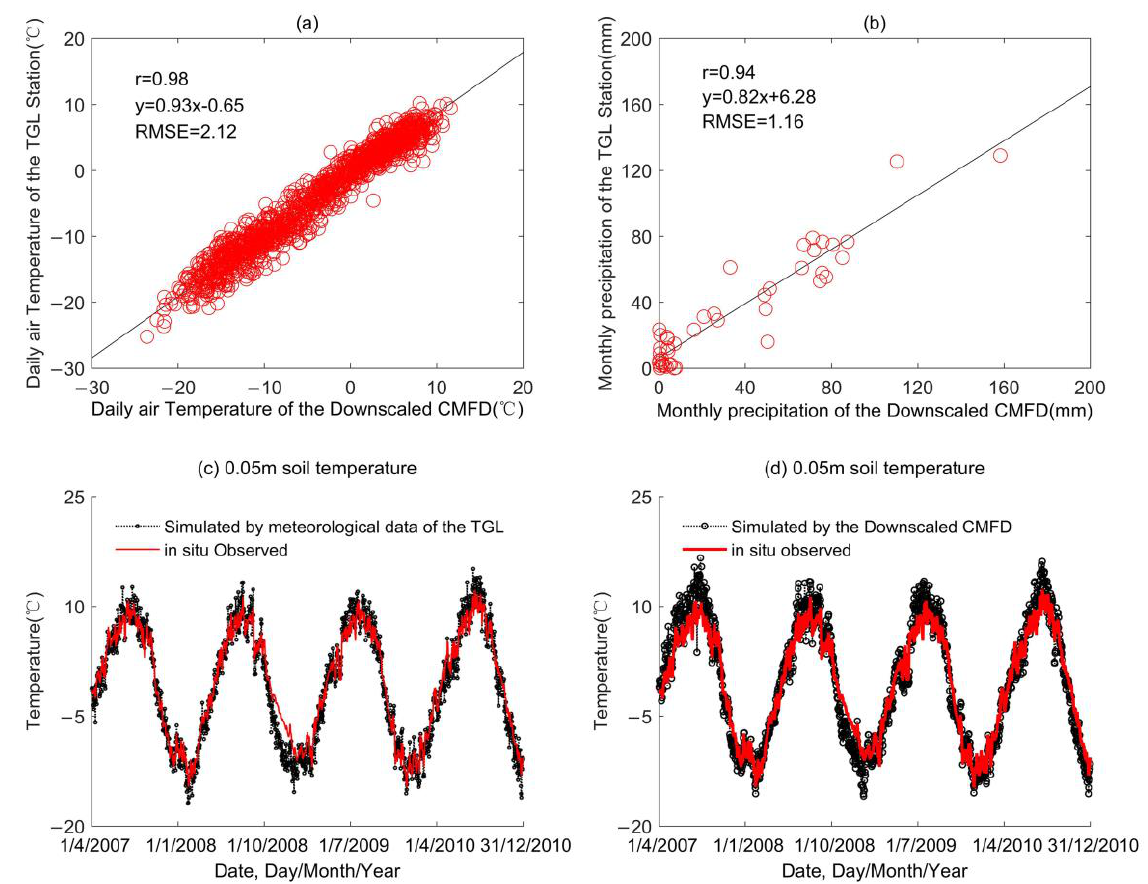
Figure 2. Plots of ( a ) the 2 m daily air temperature; ( b ) the monthly precipitation extracted from downscaled China Meteorological Forcing Dataset (CMFD) against observations of TGL station from 1 April 2007 to 31 December 2010; The observed 0.05 m soil temperature contrast to the 0.05 m soil temperature simulated using ( c ) observed meteorological data of TGL station and ( d ) downscaled CMFD data at extracted at TGL